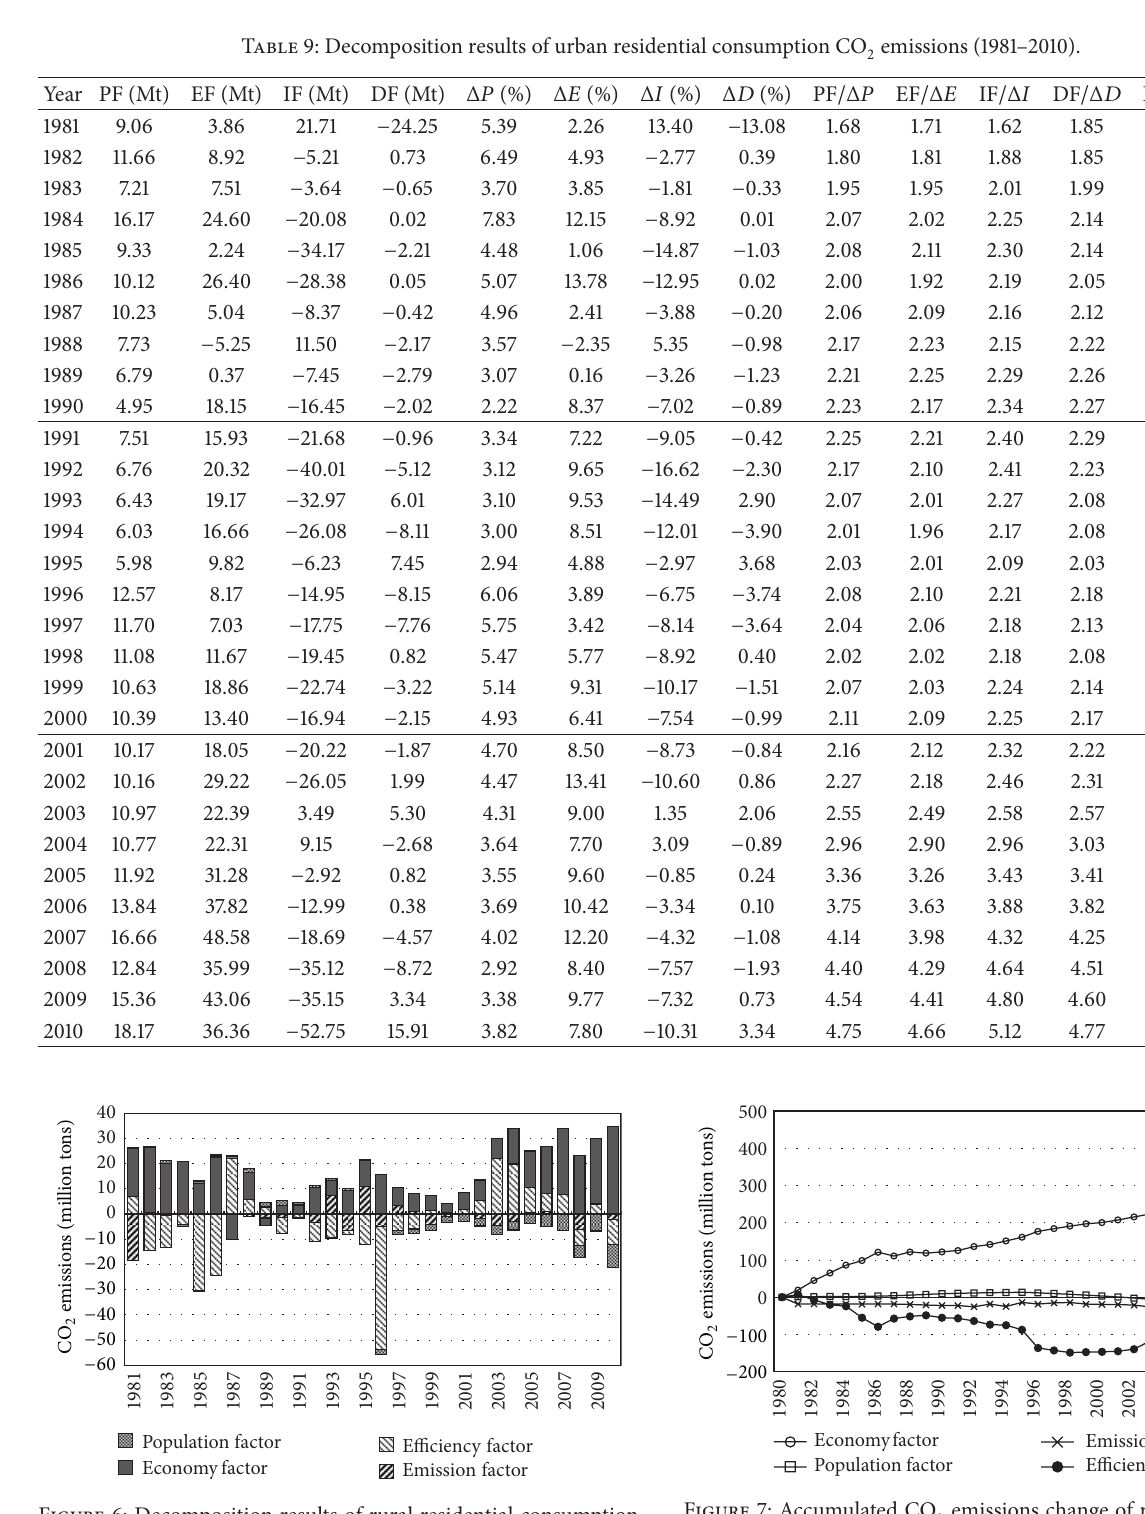
Table 9: Decomposition results of urban residential consumption CO